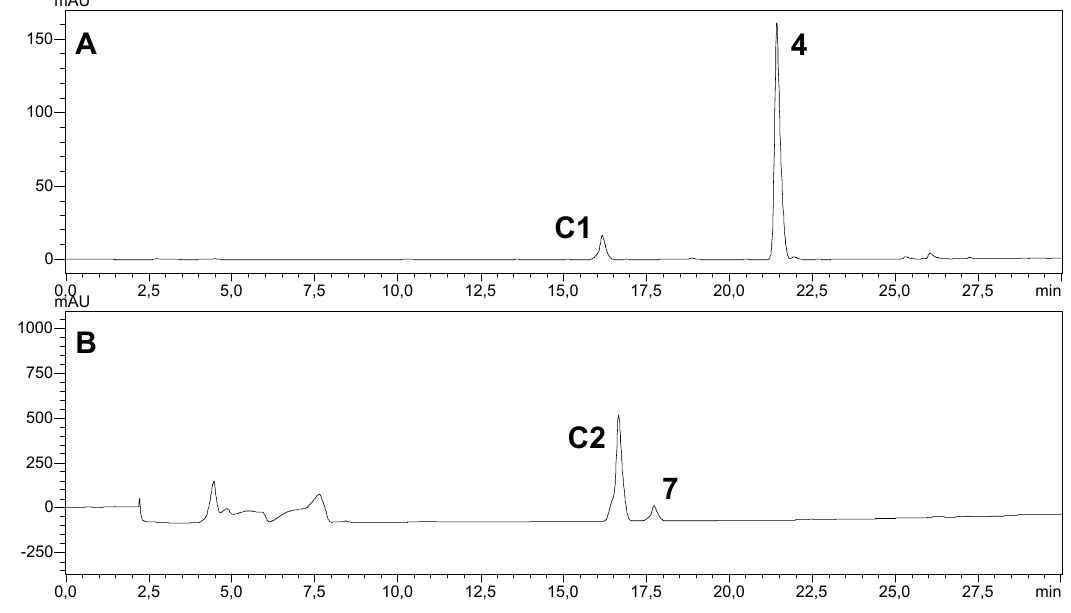
Figure 2. Reverse-phase HPLC elution profiles ( λ = 211 nm) of the ethyl acetate extracts of C. elegans ATCC 10028b cultures incubated for 72 h with coumarin 4 (chromatogram A) and A. brasiliensis ATCC 16404 cultures incubated for 72 h with coumarin 7 (chromatogram B). The derivatives of coumarins 4 and 7 can be visualized in peaks C1 and C2 , respectively. AU: absorbance unit.